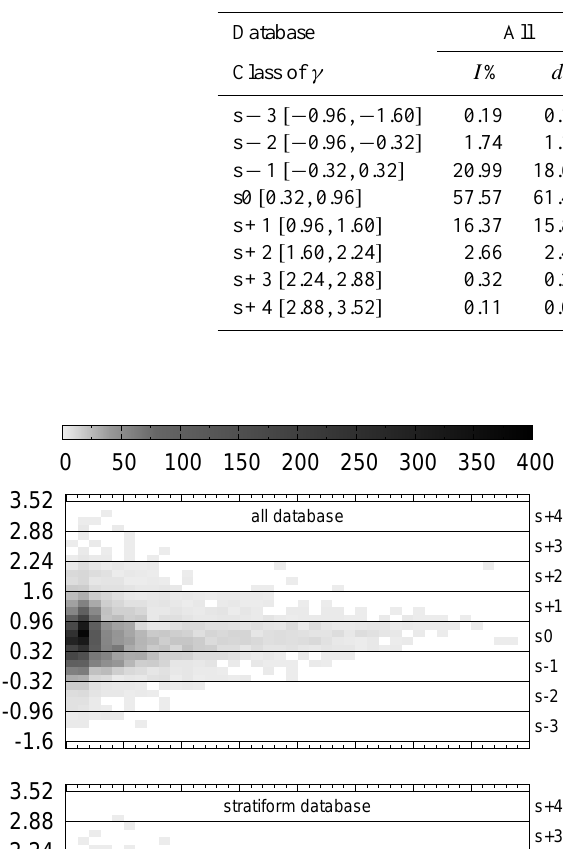
Table 1. Classification of the databases (respectively all, stratiform, and convective) in classes of skewness using the number of time intervals ( I %), and number of drops ( d %).